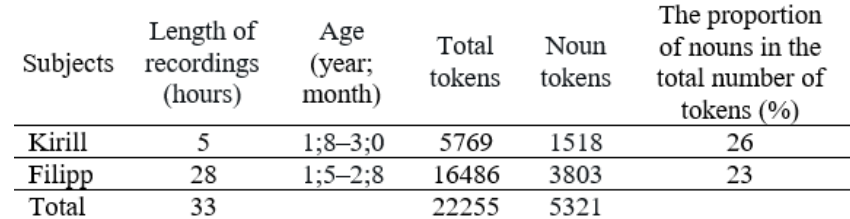
Table 1. Data: Child